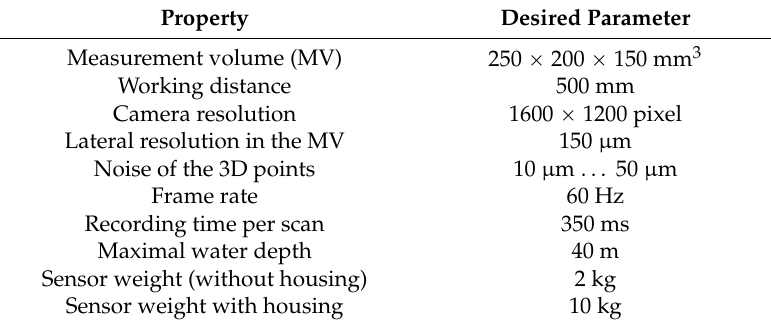
Table 1. Desired system